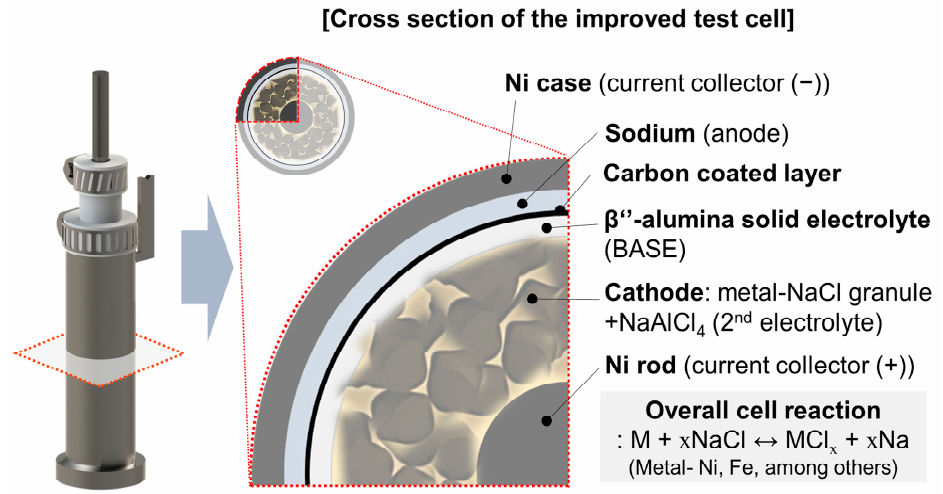
Figure 2. Schematic diagrams of tubular-type improved test cell structure and cross-section.